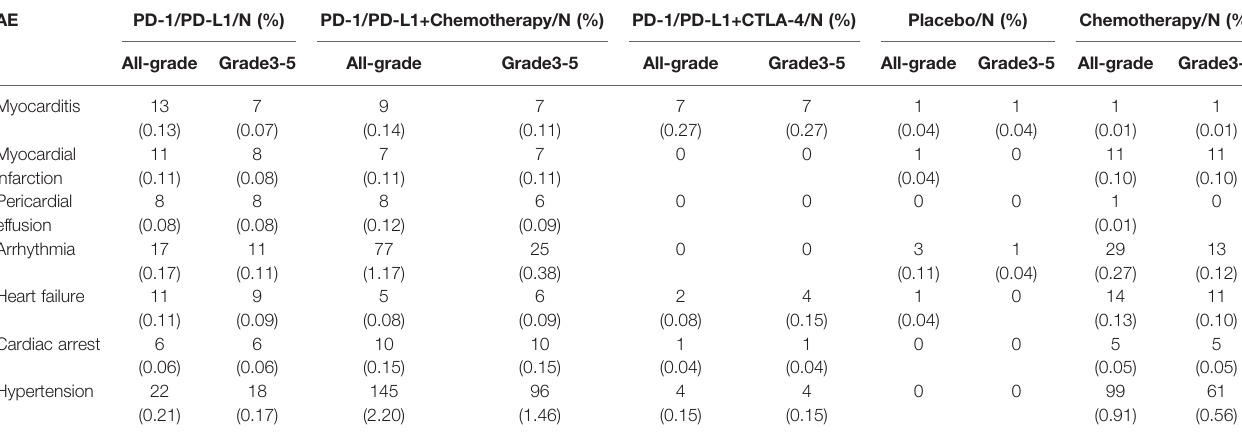
TABLE 2 | The incidence of cardiovascular toxicity in different treatment groups. .